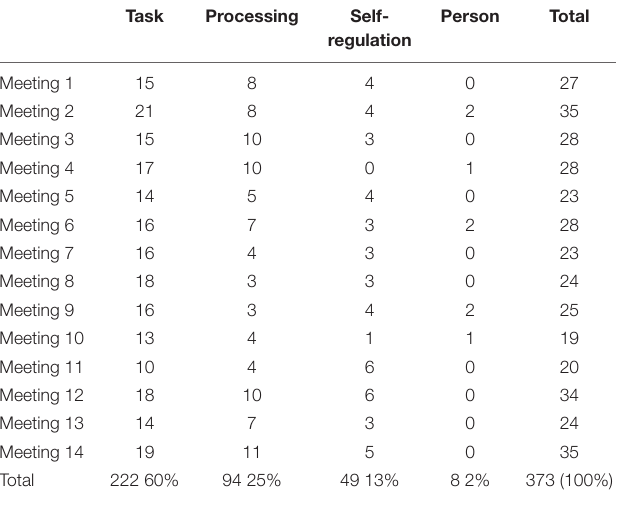
TABLE 3 | Distribution of comments at different feedback levels in